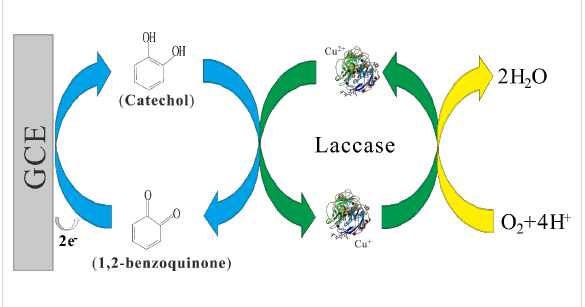
Figure 6: Schematic representation of laccase-catalyzed oxidation of catechol with its subsequent electrochemical reduction on the